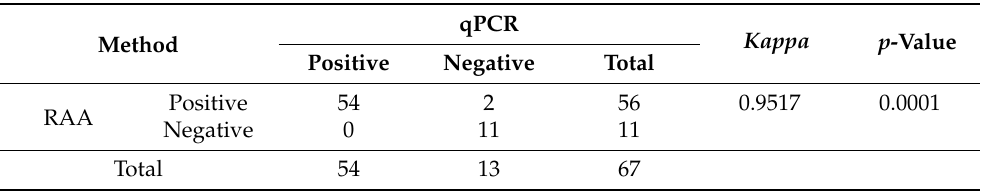
Table 2. Detection performance comparison between the mecA -based real-time RAA and qPCR assays for the detection of MRSA on S. aureus clinical isolates.